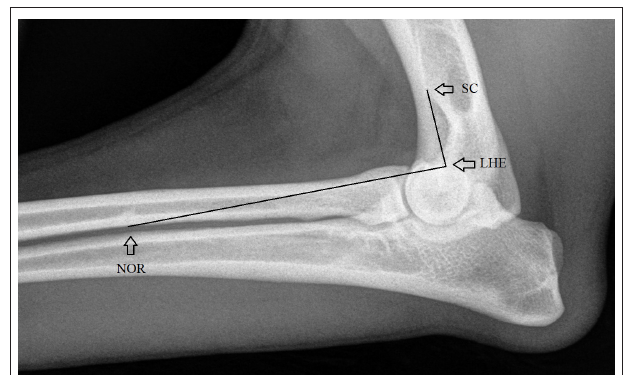
FIGURE 2 | Anatomical landmarks used for measuring the elbow angles, the angular point in the lateral humeral epicondyle (LHE) (contact point of cranial border of medial epicondyle with the condyle) and the linking points at the nutrient orifice of the radius (NOR) and the intersection point of the lateral supracondylar crest and the cranial humeral endosteum (SC) (